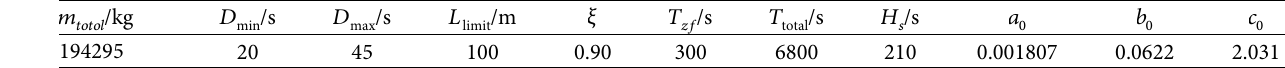
Table 5: Other parameters used in the